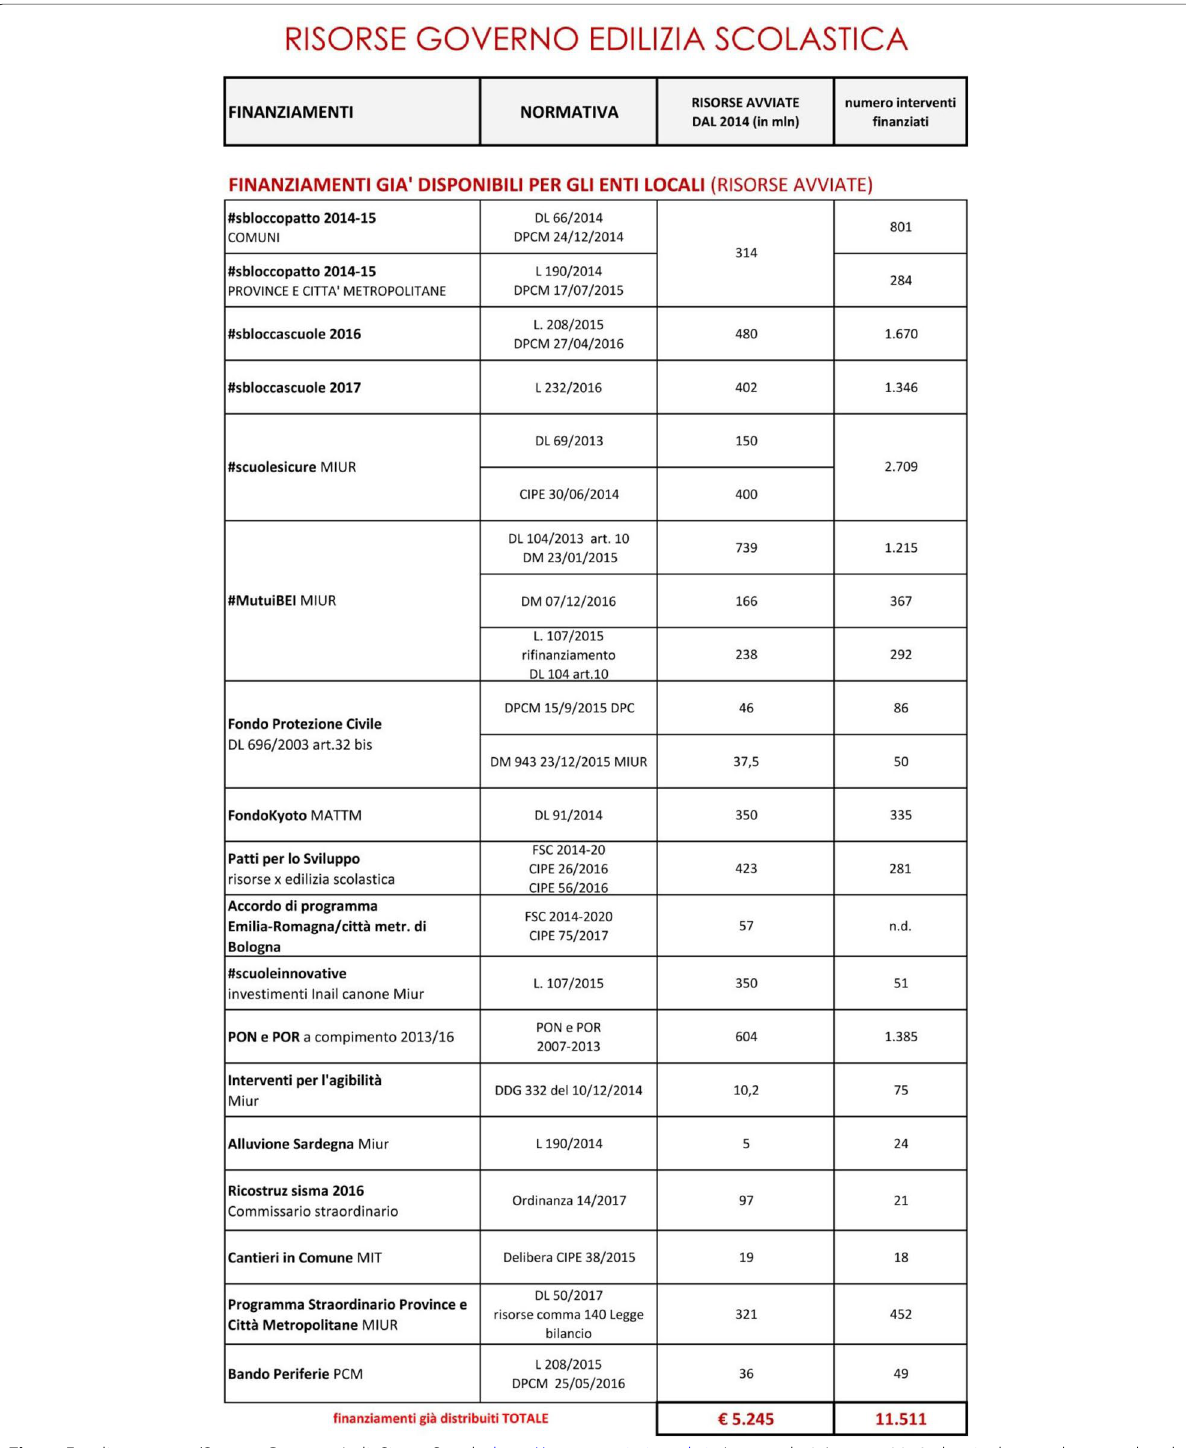
Fig. 5 Funding source. (Source: Governo. ItaliaSicura Scuole. http://www.canti erisc uole.it Accessed 10 January 2018, the site has not been updated since the SMES closure, since January 2019 no longer available